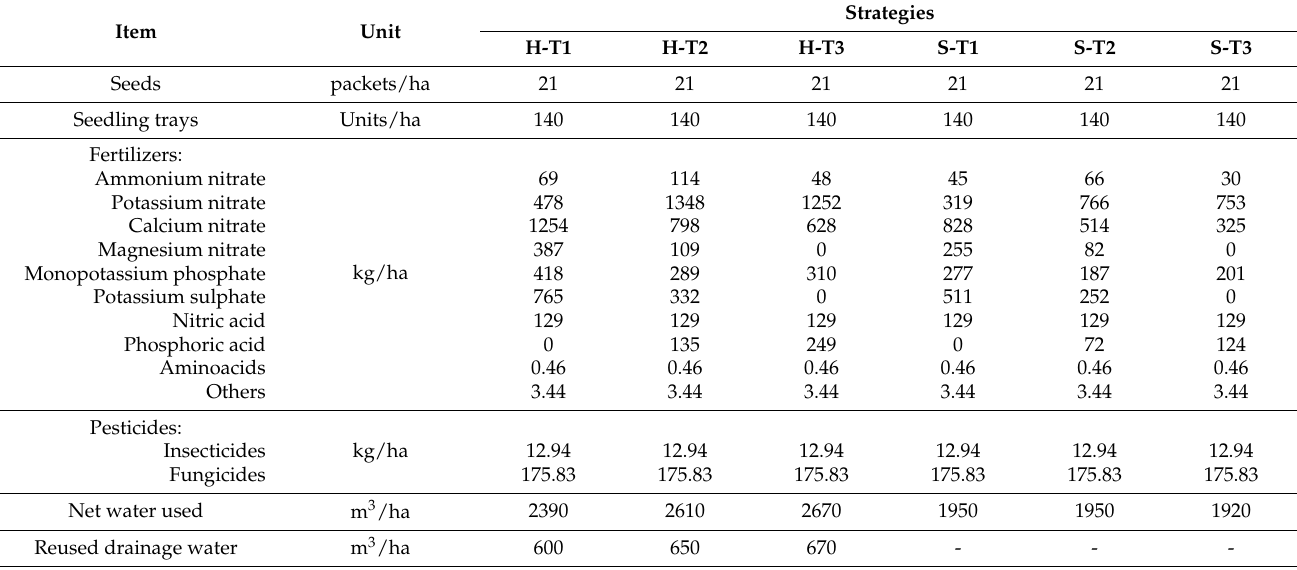
Table 1. Inventory of variable inputs, crop yields and environmental impacts per crop